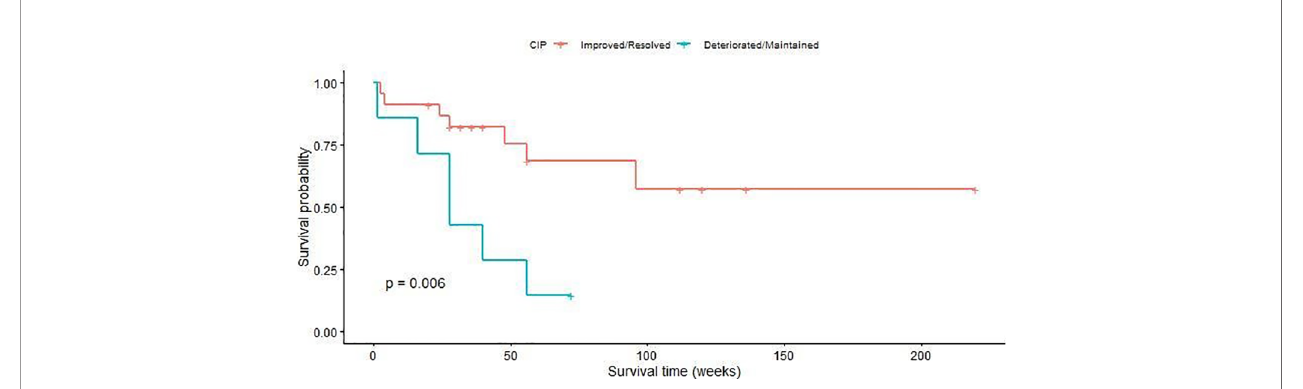
FIGURE 5 | Overall survival curves of patients with checkpoint inhibitor